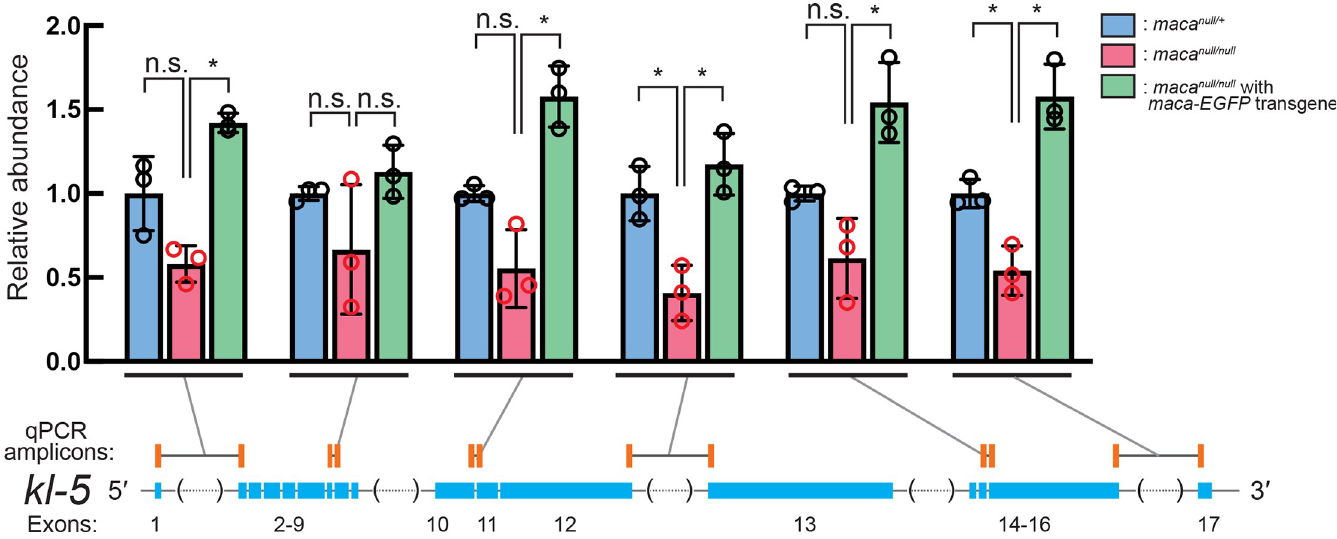
Fig 11. RT-qPCR of kl-5 transcripts shows their reduction in maca null/null testes. Quantification of kl-5 transcripts in testis RNA by RT-qPCR. The RT step was performed with random hexamer primers. qPCR amplicons targeted by designed primer sets are indicated by orange bars. The primers span exon-exon junctions to amplify only spliced transcripts. Black lines indicate intron regions not included in the amplicons. Data were normalized to actin5C mRNA and the mean of maca null/+ . Mean +/- SD (n = 3 biological replicates). P-values < 0.05 (Student’s t-test, unpaired, two-tailed) are indicated by � .